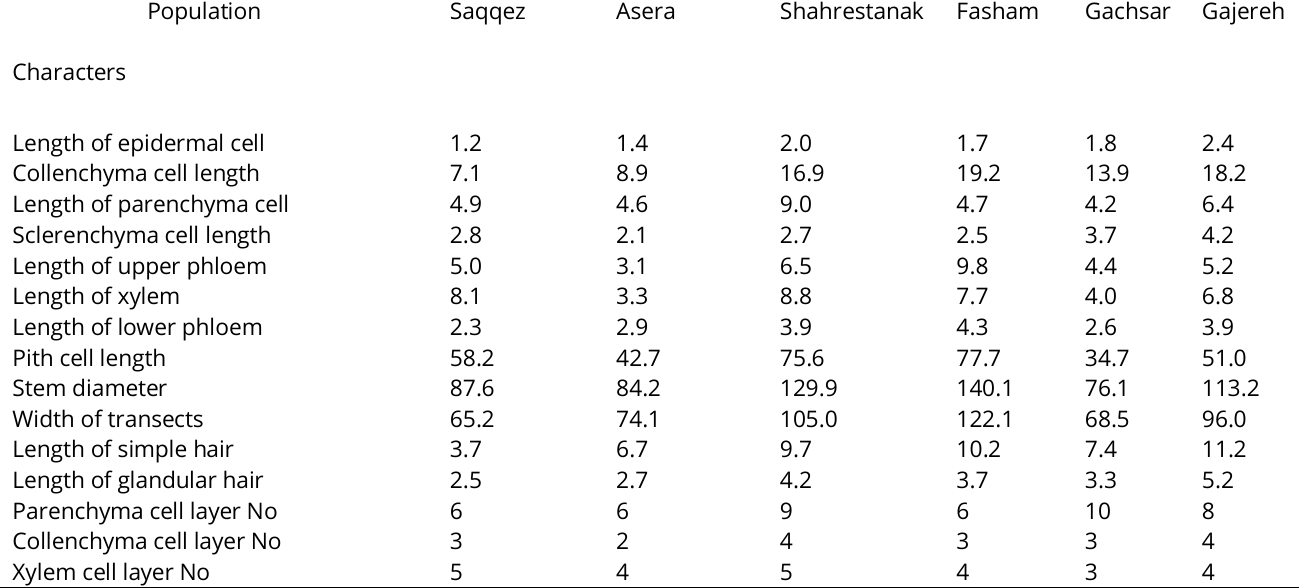
Table3. Details of anatomical features in L. peltata populations studied (all values are in µm).